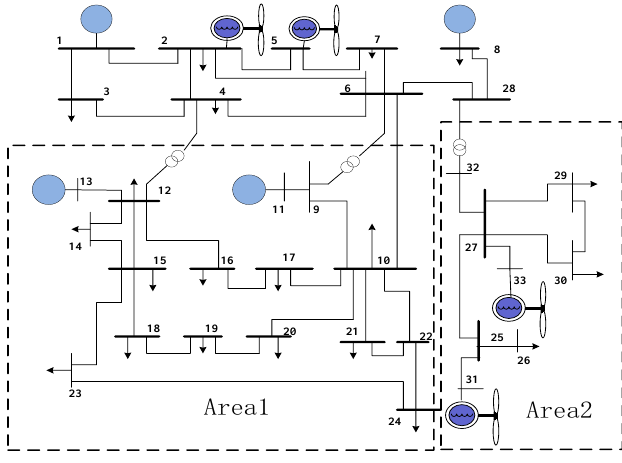
Figure 3. Modified IEEE-30 Bus System. Table 1. Power outputs of distributed generations (DGs) under the extreme voltage scenario.